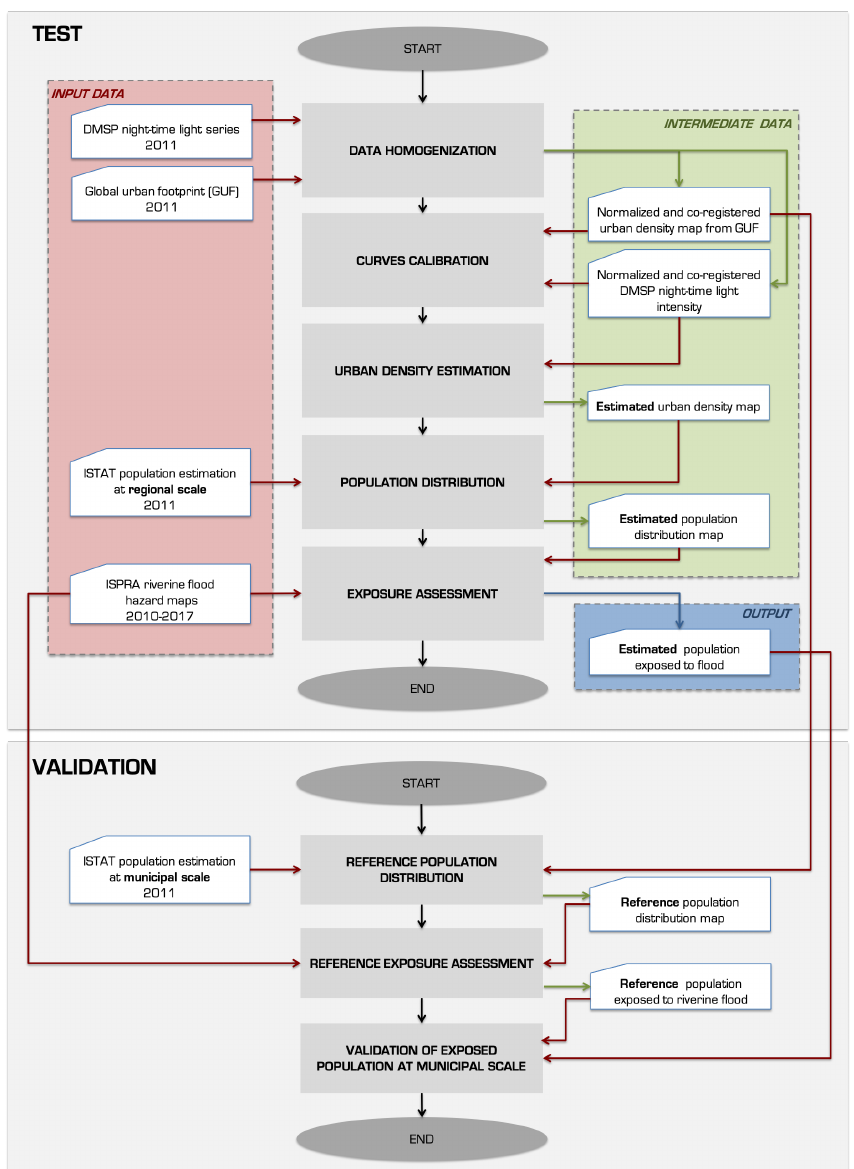
Figure 3. Graphical representation of the workflows performed to test and validate the proposed methodology, applied for the assessment of the number of people exposed to riverine flood in